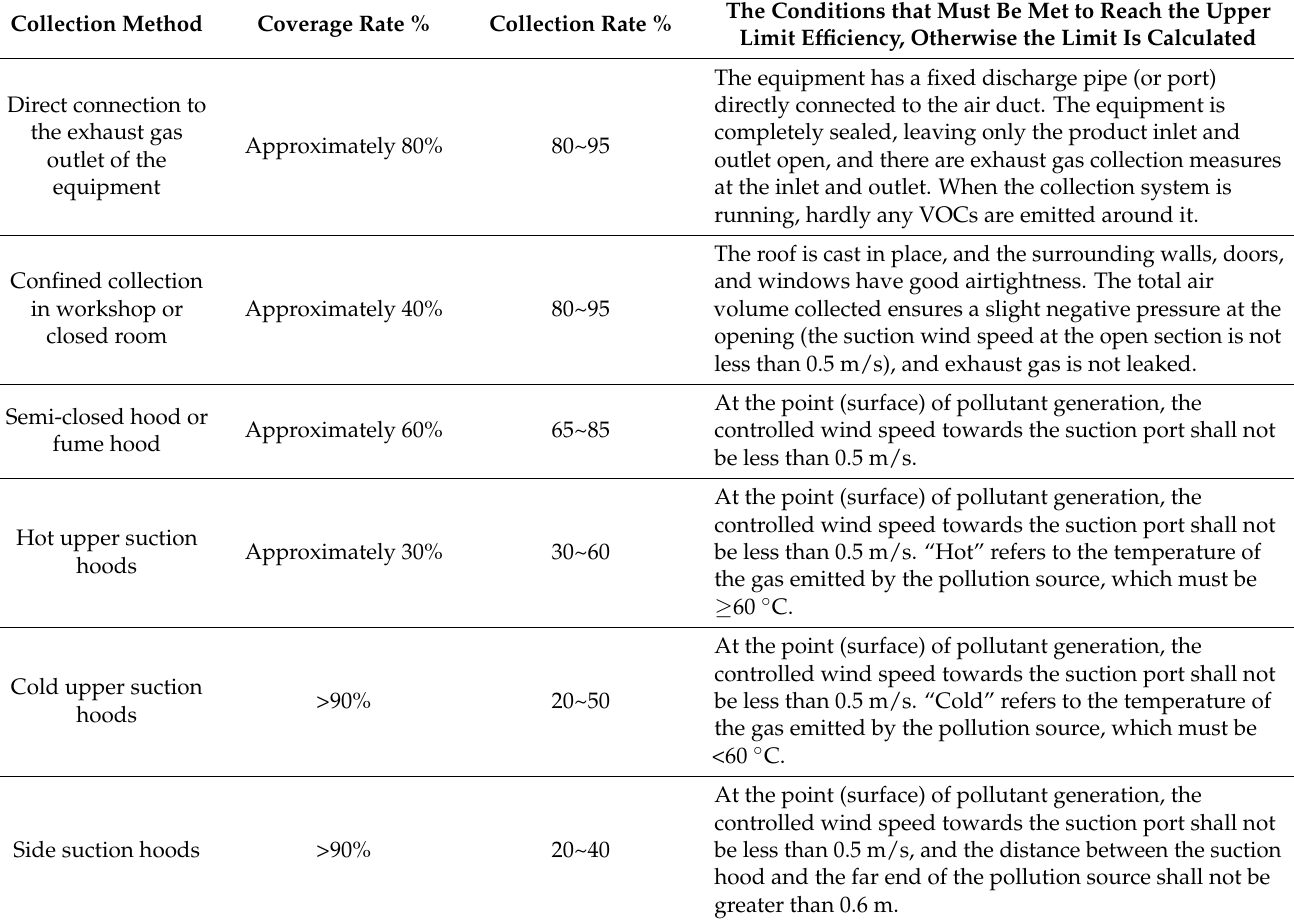
Table 6. Collection rate of VOCs in the pesticide